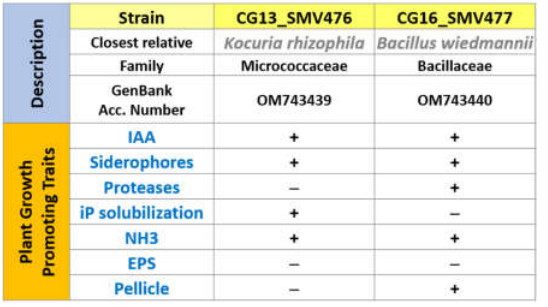
Figure 5. Description of the growth-promoting properties shown by the two strains CG13 and CG16 chosen as inoculum for the phytoremediation tests.